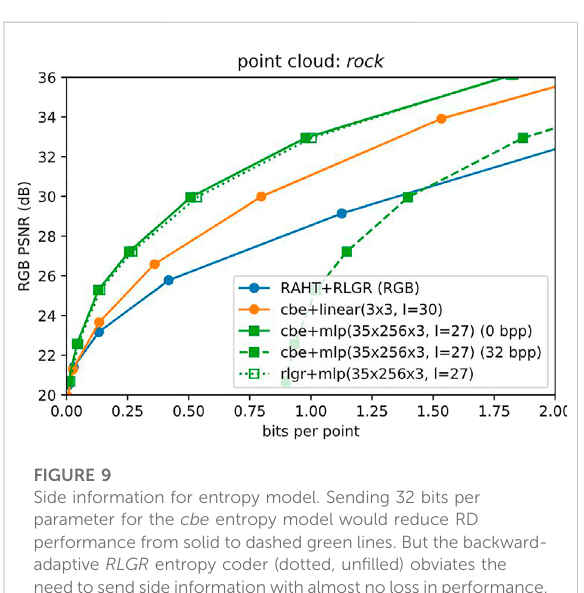
FIGURE 9 Side information for entropy model. Sending 32 bits per parameter for the cbe entropy model would reduce RD performance from solid to dashed green lines. But the backward- adaptive RLGR entropy coder (dotted, un fi lled) obviates the need to send sideinformation with almost no loss in